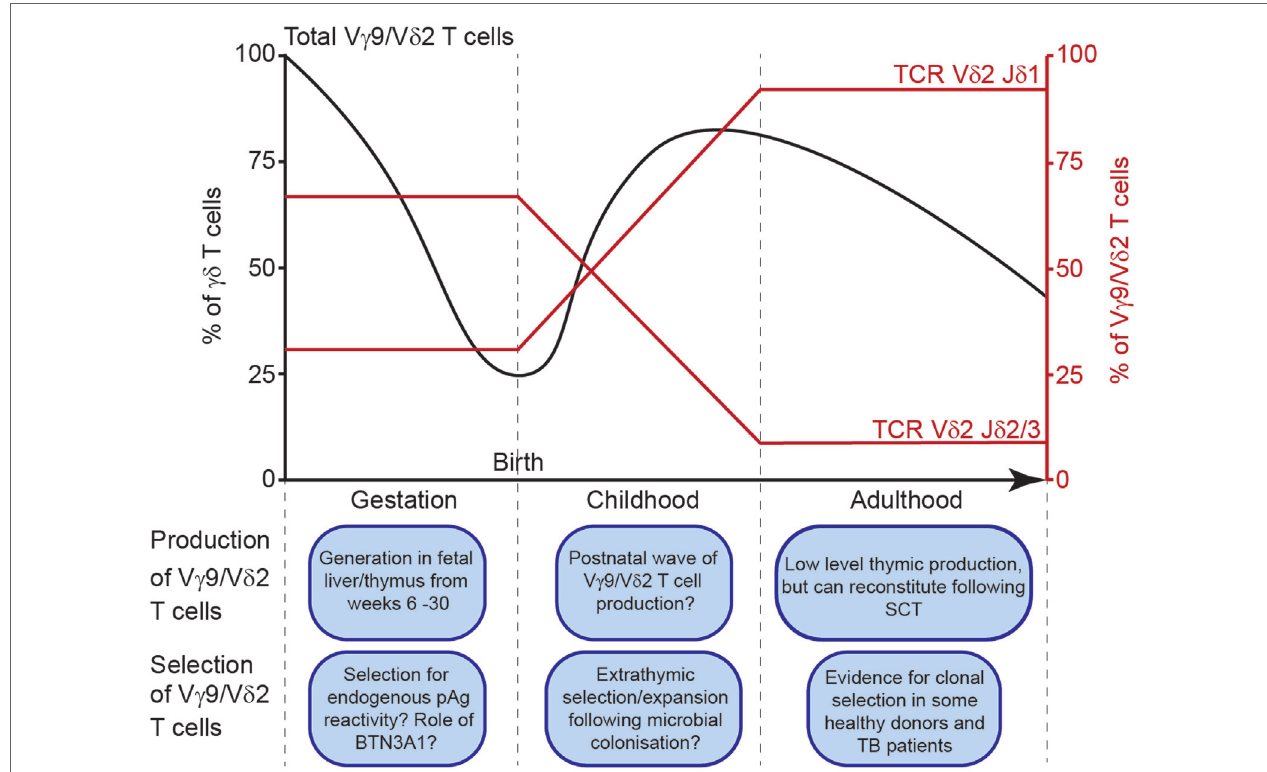
FiguRe 1 | Schematic depiction of V γ 9V δ 2 + T cell generation and selection throughout life. V γ 9V δ 2 + T cells as a percentage of total peripheral blood γδ T cells throughout life (black line, left axis). J δ usage among V γ 9V δ 2 + T cells (red lines, right axis) throughout